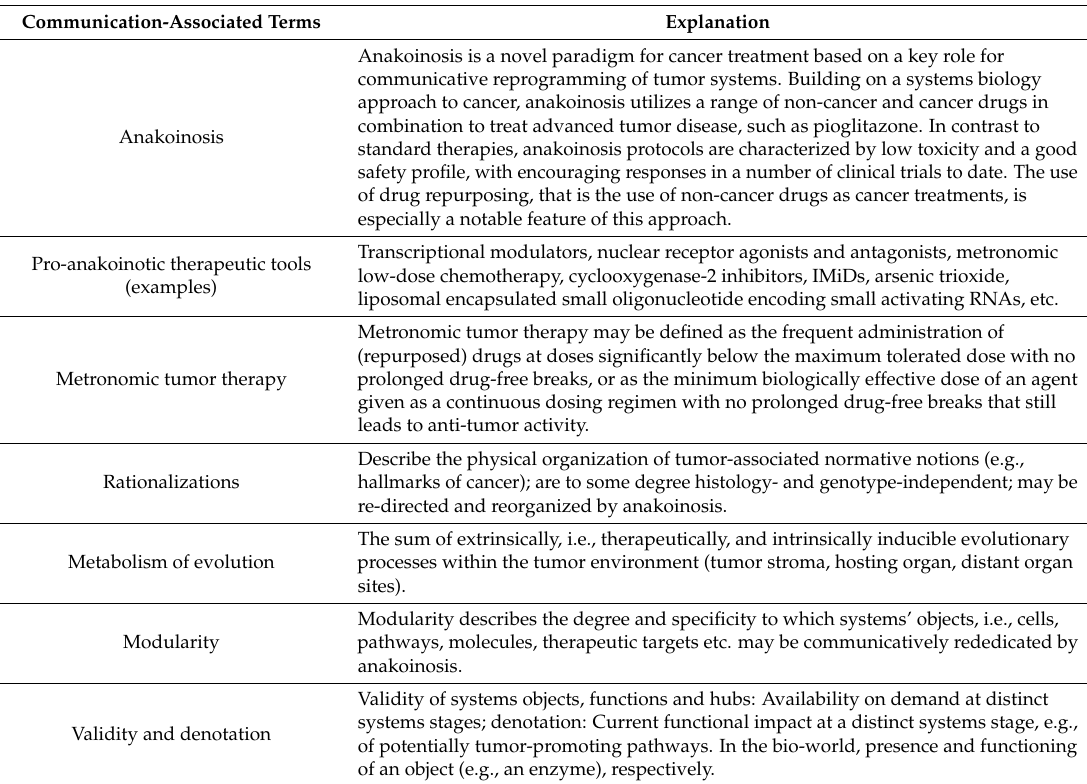
Table 1. Explanation of communication-associated